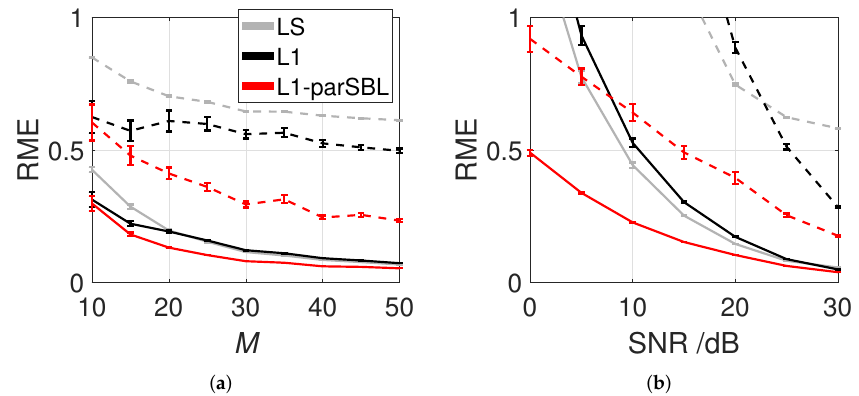
Figure 9. (Color online) RME of LS, L1, and L1-parSBL (—: Inside; - -: Outside ) ( a ) versus M (the number of samplings) with SNR = 25 dB, and ( b ) versus SNR with M = 40 for the mode at approximately 106.5 Hz with R = 400.